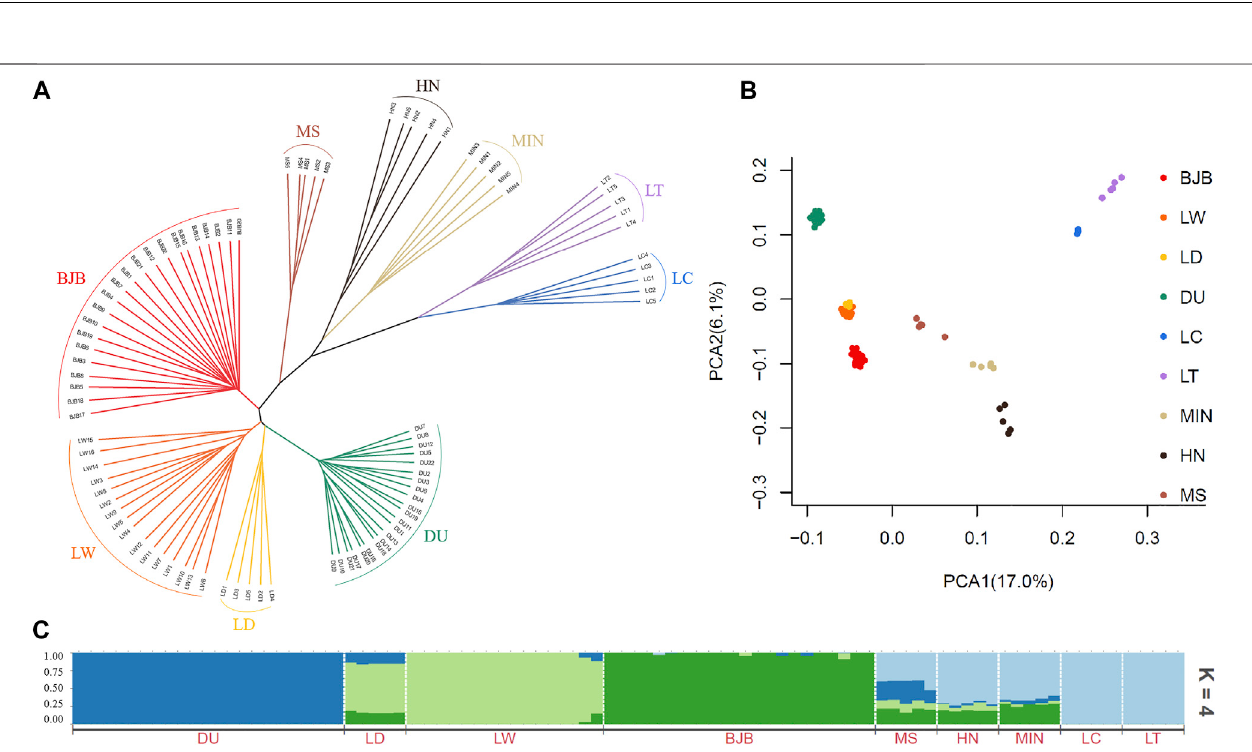
FIGURE2| PhylogeneticrelationshipandpopulationstructureofBeijingBlackandothereightbreedstestedinthisstudy.BJB,BeijingBlackpig;HN,Huainanpig; MS, Mashen pig; LT, Lantang pig; LC, Luchuan pig; MIN, Min pig; DU, Duroc; LD, Landrace; LW, Large White. (A) Neighbor-joining phylogenetic tree constructed from SNV data among nine populations. (B) Principle component analysis for the fi rst two PCs of 90 pigs. (C) ADMIXTURE analysis with four presumed ancestral groups (K = 4).